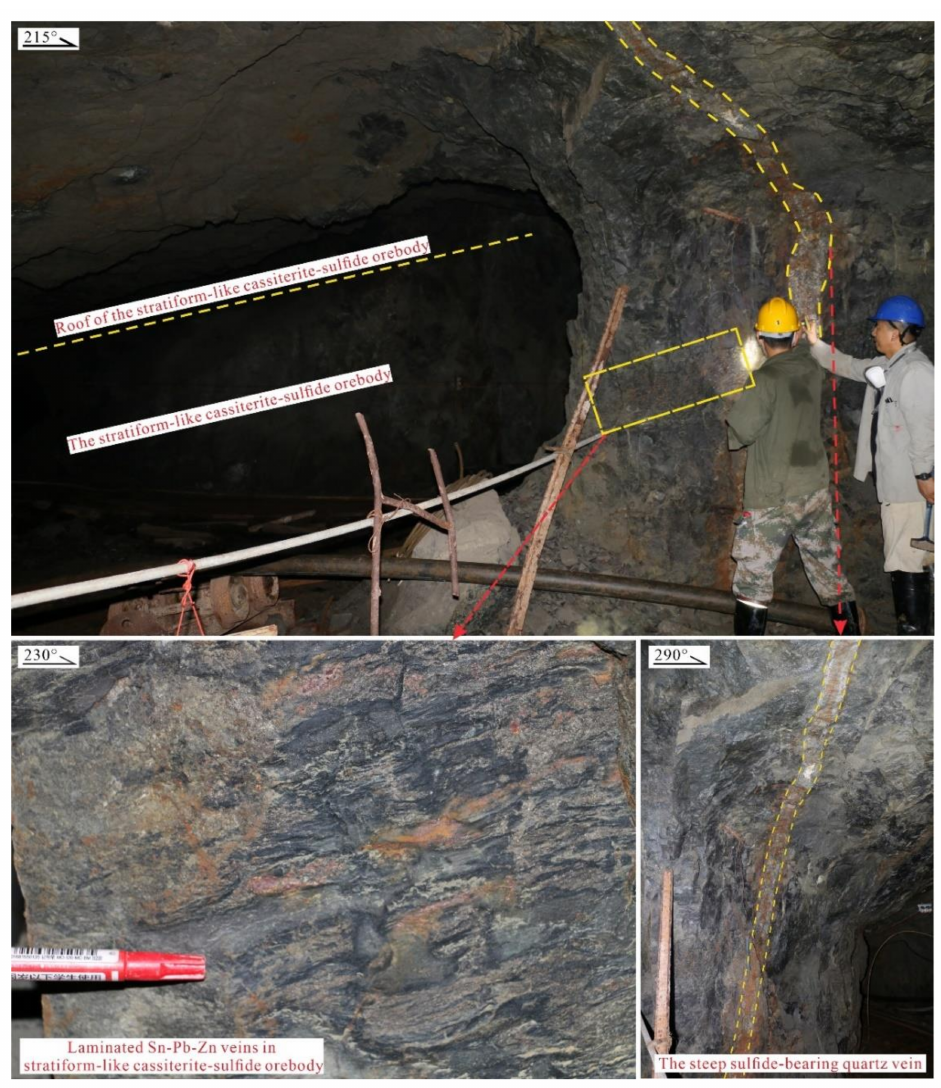
Figure 14. Photos of the cut-through relationship between the steep sulfide-bearing quartz vein and the stratiform-like cassiterite–sulfide orebody in the Laohuya mining area. Even extended to the entire Nanling region, the Late Jurassic stage is the main stage of tungsten–tin-related magmatism and mineralization, which is also concentrated in the 160–150 Ma range and is fully consistent with the XHLOF, such as the Qianlishan intrusion and the adjacent Shizhuyuan tungsten–polymetallic deposit [4–7], the Qitianling intru- sion [24] and related Furong tin deposit [23], the Yaogangxian intrusion [19] and the related tungsten deposit [18], the Xihuashan intrusion [8,10] and the related tungsten deposit [9], and the Taoxikeng intrusion and the related tungsten deposit [14]. Deposits formed during the Cretaceous stage (130–90 Ma) include the Jiepailing tin deposit (91–89 Ma, [17,66]), the Shanhu tin deposit [67], and the Yanbei tin deposit (133–130 Ma, [68]). Among these, the Jiepailing is the closest to the XHLOF in distance, which is about 70 km east of the XHLOF. The chronological data of the two phases in the XHLOF and the Nanling area are highly consistent, which indicates that the magmatism of the Late Cretaceous stage in the XHLOF is reasonable, and it is the product of the same specific tectonic setting in the Nanling